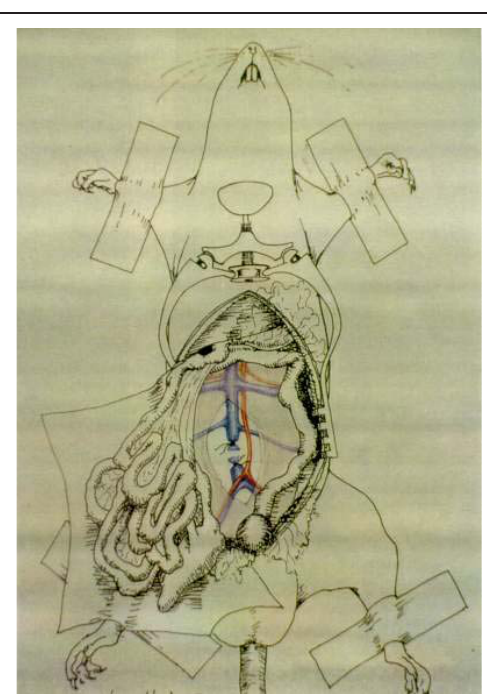
FIGURA 1 - Grupo II, ligadura da veia cava caudal abaixo FIGURA 2 - Grupo III, ligadura da veia cava caudal acima das veias